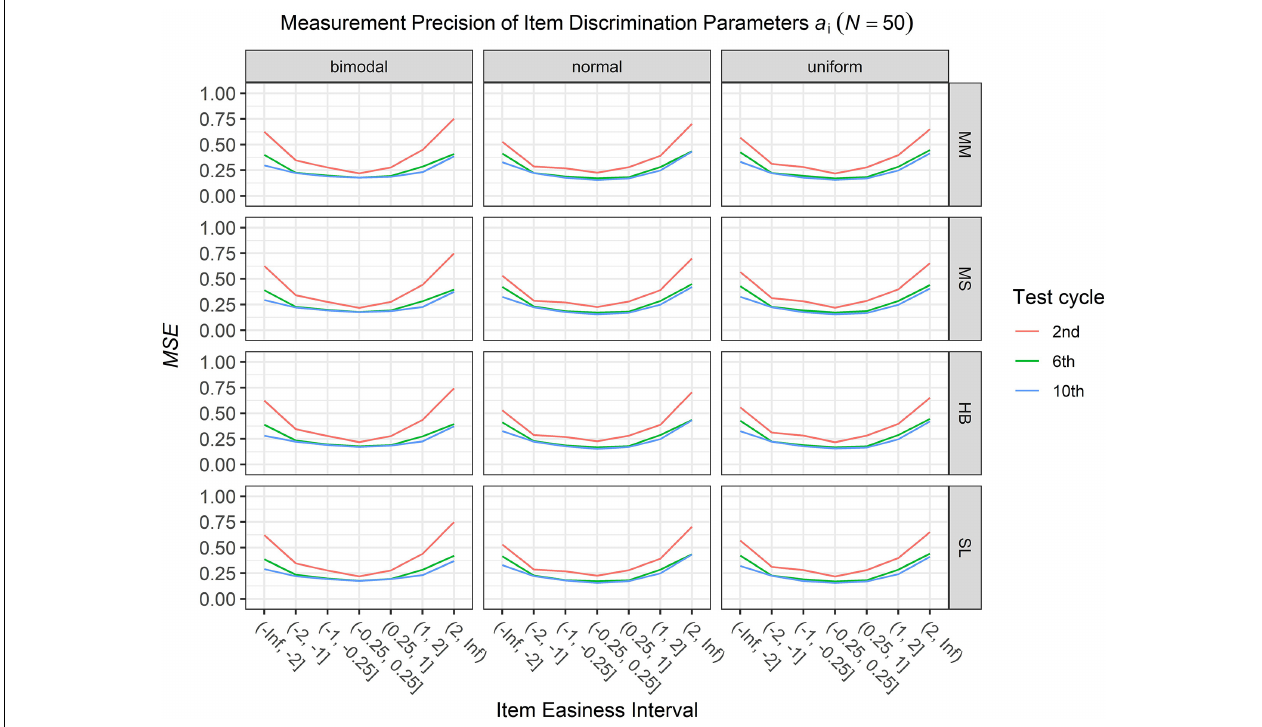
FIGURE 1 | Conditional mean squared error ( MSE ) of the item discrimination a i for specific item easiness intervals after the 2nd, 6th, and 10th test cycles in the continuous calibration strategy with a sample size per test cycle of N = 50 for different common item difficulty distributions and different scale transformation methods (MM = Mean/Mean, MS = Mean/Sigma, HB = Haebara, SL =